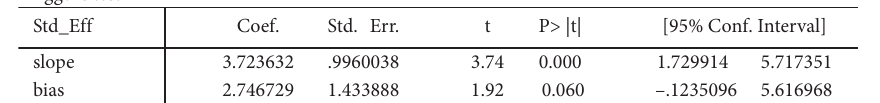
Figure 5: Egger’s test to show publication bias on the pooled proportion of chromosomal disorders among births with congenital anomalies in Africa from January, 2000 to October,